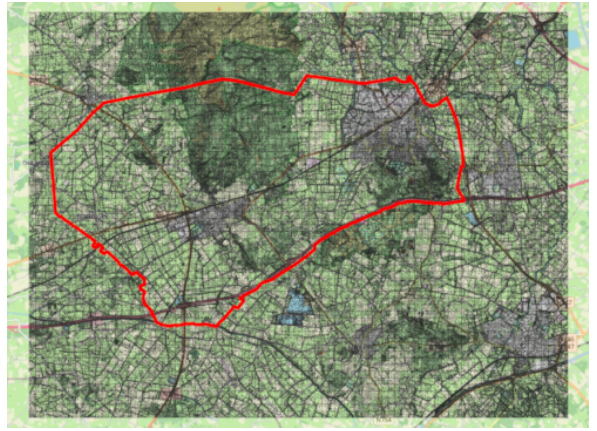
Figure 10. TIN of Rijssen-Holten